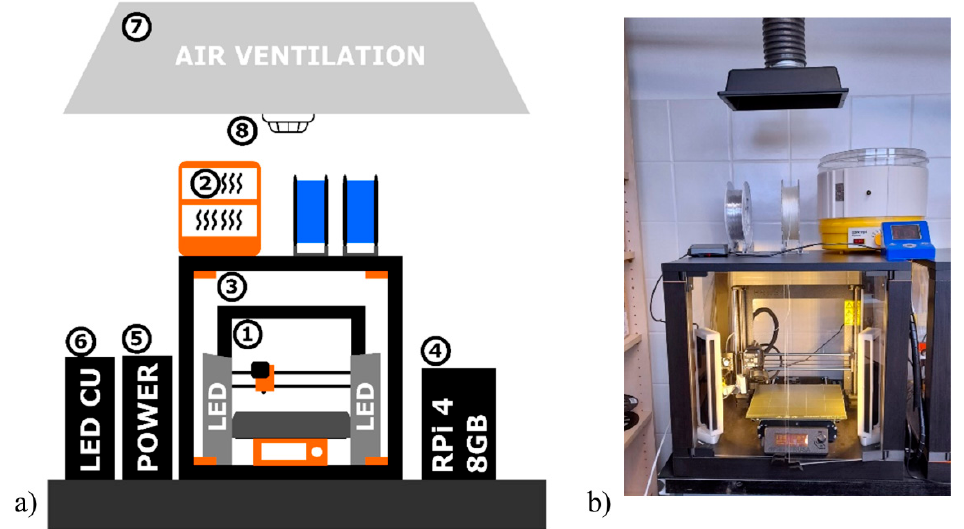
Figure 2. ( a ) Diagram of a custom-built 3D printing workspace: (1) 3D printer; (2) custom filament dryer; (3) custom cover box; (4) RPi 4 for remote system control; (5) external power source; (6) LED control unit (LED CU); (7) air ventilation system; and (8) fire alarm. ( b ) The actual photo of the printer.